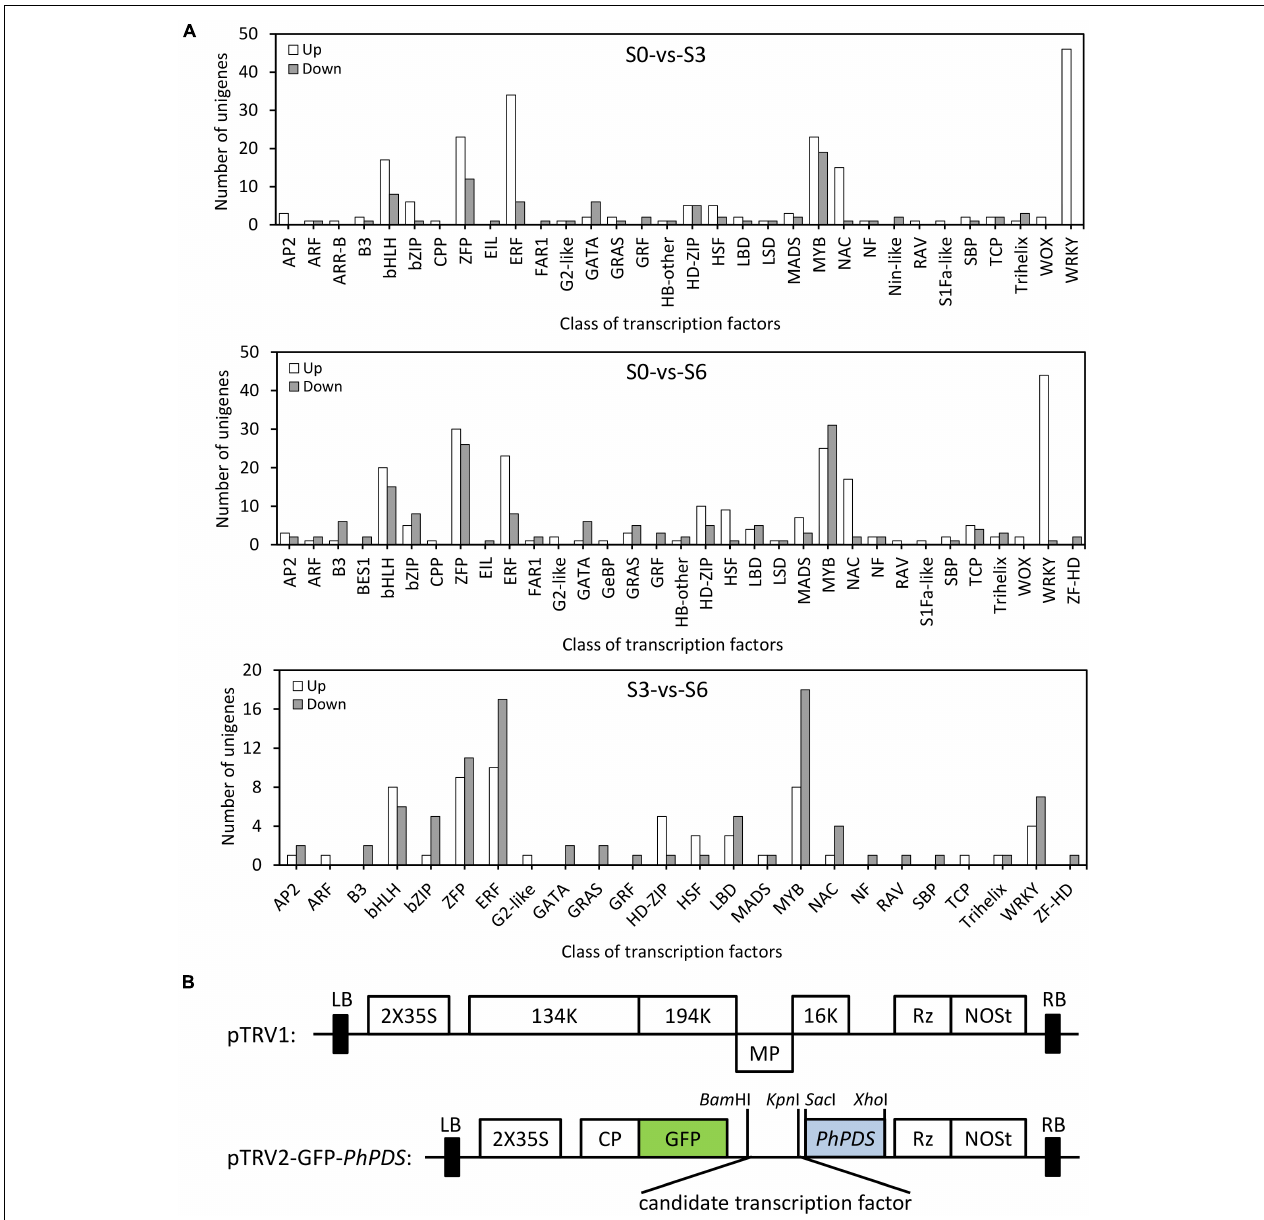
FIGURE 5 | Distribution of differentially expressed transcription factors in petunia leaves upon TRV PPK20 infection. (A) Number of up-regulated (up) and down-regulated (down) transcription factors in TRV (PPK20)-inoculated petunia leaves for the pairwise comparisons of S0-vs.-S3, S0-vs.-S6, and S3-vs.-S6. (B) Schematic diagram of the TRV-GFP- PhPDS construct carrying the fragment of candidate transcription factor.